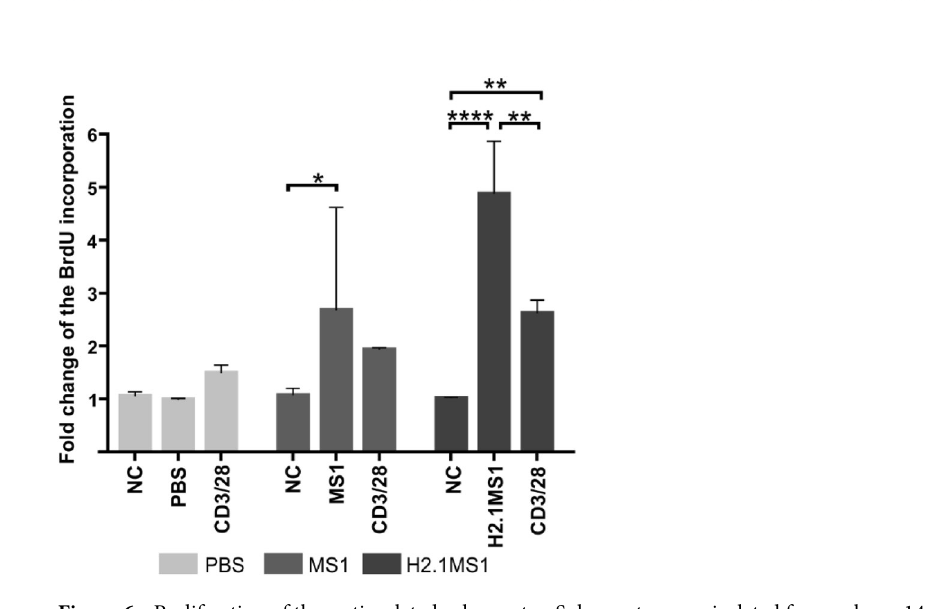
Figure 6. Proliferation of the restimulated splenocytes. Splenocytes were isolated from spleens 14 days after intravenous administration of PBS or MS1 or H2.1MS1 spheres. The cells were unstimulated (NC), stimulated with anti-CD3/CD28 antibodies (CD3/CD28), or accordingly challenged in vivo with PBS (PBS) or MS1 (MS1) or H2.1MS1 (H2.1MS1) particles. After 72 h, cell proliferation was measured using a BrdU assay. The results are expressed as the fold change of BrdU incorporation in relation to the corresponding control group without stimulation. The results are expressed as means ± SD. ****Indicates significance with p ≤ 0.0001, ** p ≤ 0.01, and * p ≤ 0.05.